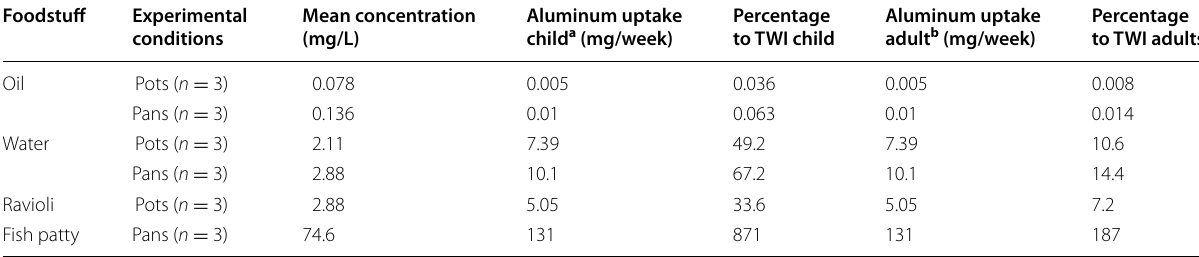
a Results are for a child weighing 15 kg based on a daily uptake of 10 mL oil or of 500 mL water or 250 g ravioli or fish patties for a period of 1 week (7 days) b Results are for an adult weighing 70 kg based on a daily uptake of 10 mL oil or 500 mL water or 250 g ravioli or fish patties for a period of 1 week (7 days)